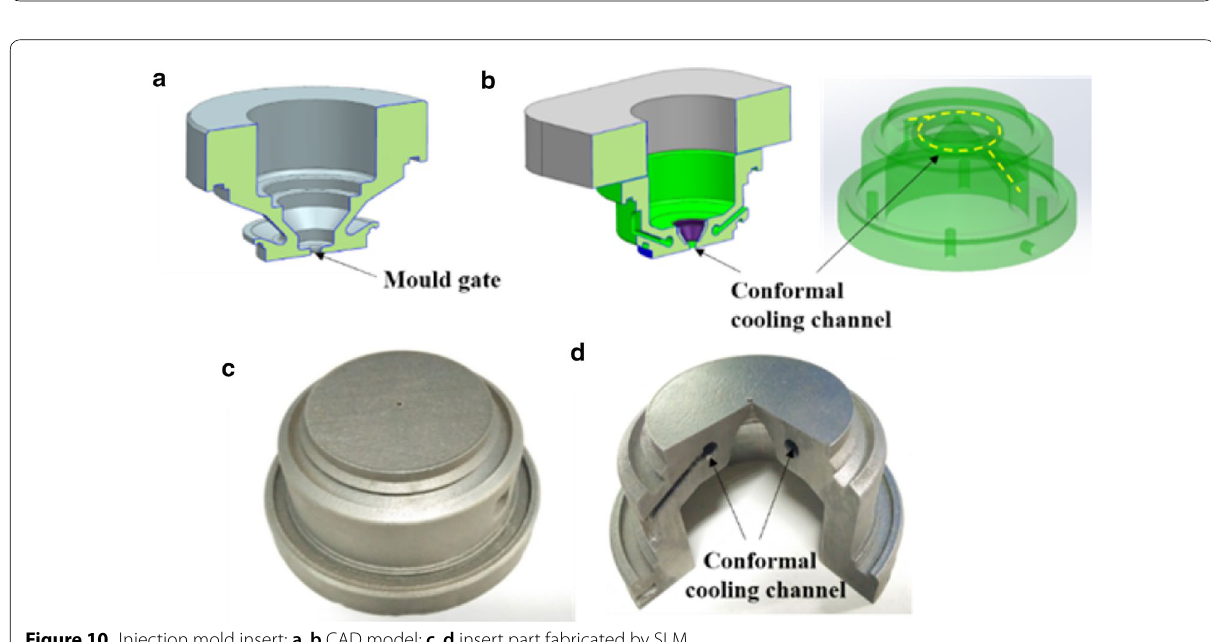
Figure 10 Injection mold insert: a , b CAD model; c , d insert part fabricated by SLM